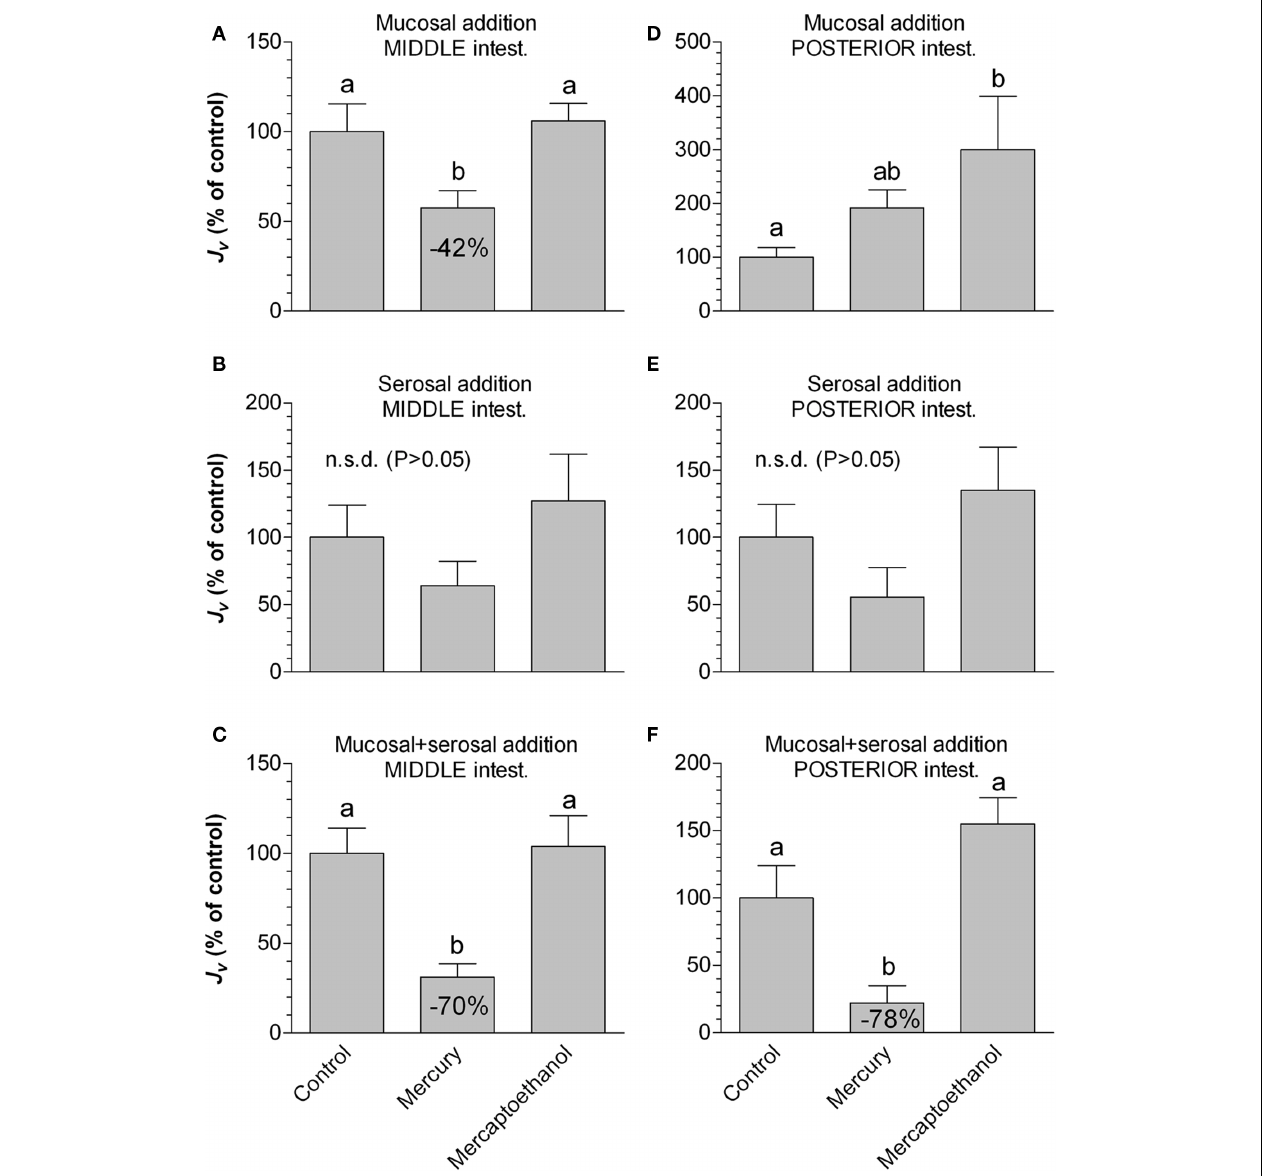
FIGURE 5 |The effect of mercury and subsequent mercaptoethanol on water transport rate ( J v in % of control values) in non-everted sacs of middle (A–C) and posterior (D–F) segments of intestine from SW-acclimated rainbow trout. In different series the test agents were added to either the mucosal (A–D) , serosal (B–E) , or both sides simultaneously (C–F) . Bars sharing identical letters are not significantly different ( p > 0.05).Values represent mean ± SEM, n =